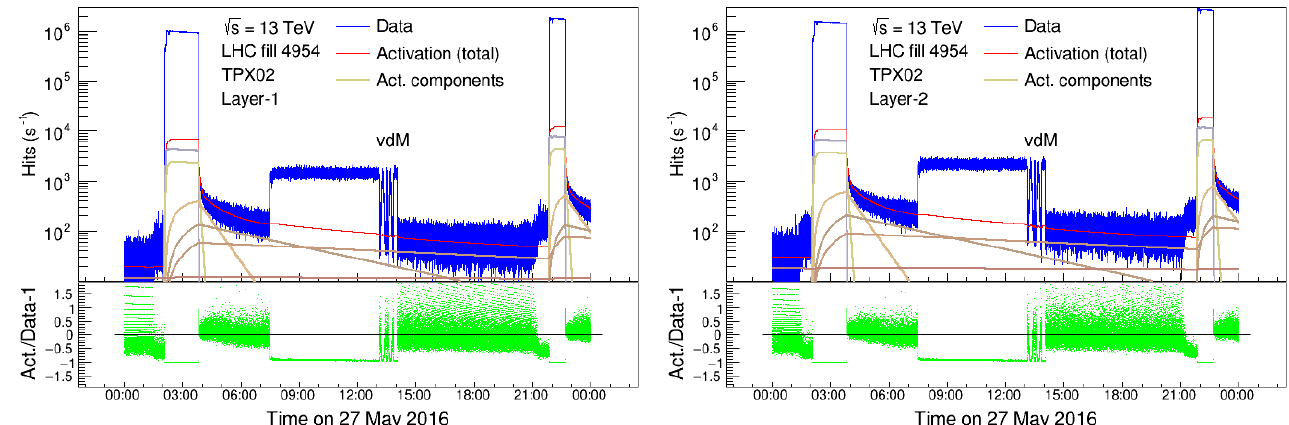
Figure 47. Hit rate measured with with TPX02 layers 1 and 2 before and after the vdM scan on 27 May 2016 as a function of time, as described in Figure 46. LHC vdM fill 4954. Taken from Ref.